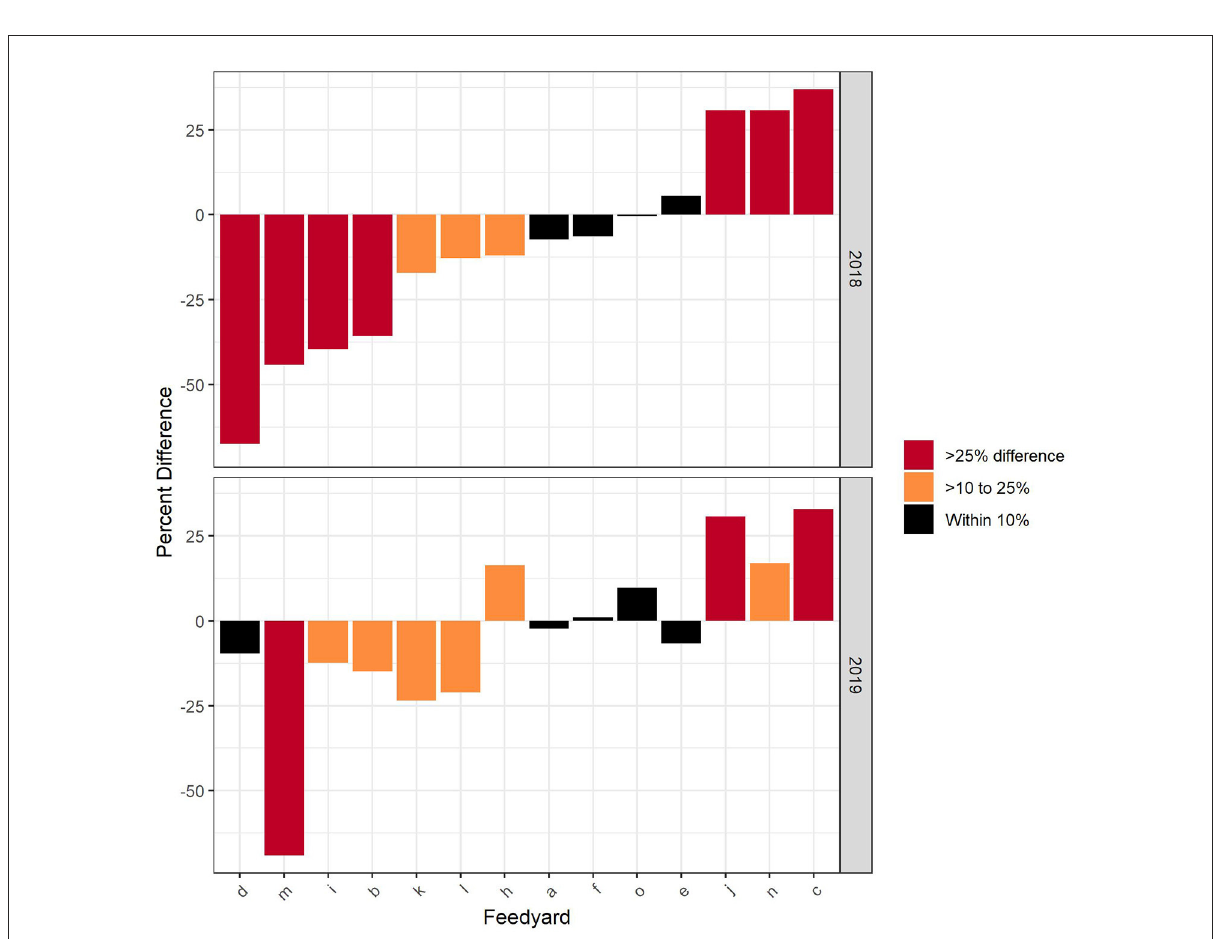
FIGURE1 Comparison of CDoA and nDDD at the feedyard level with the difference expressed as the percentage of CDoA for each feedyard.